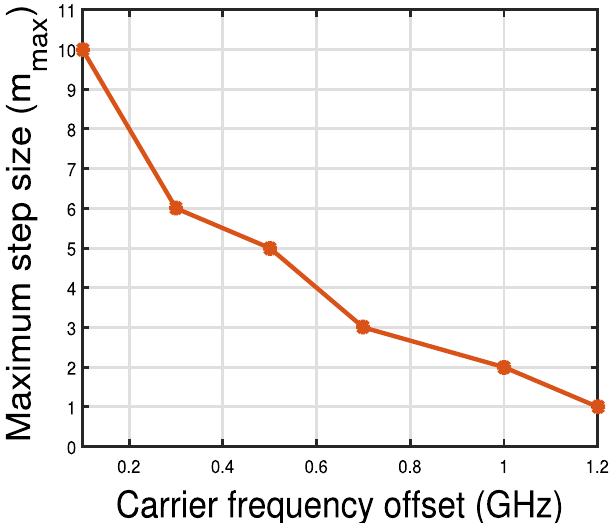
Figure 10. Maximum achievable step size for various frequency offsets for 2 state MKF.